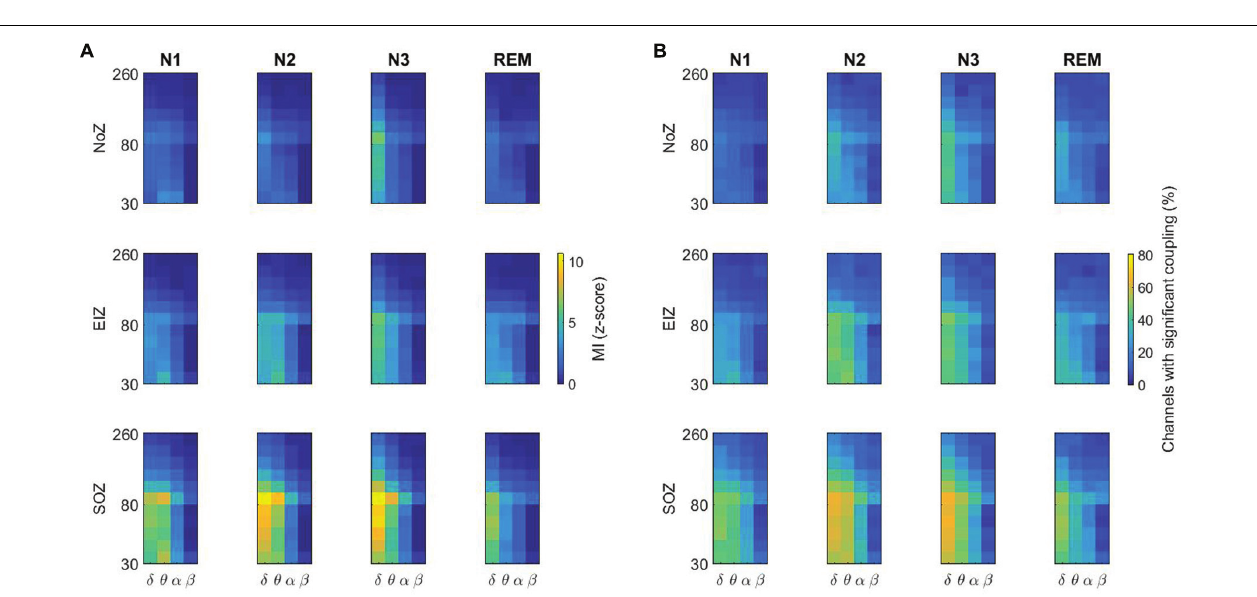
FIGURE 4 | Average PAC quantified by MI in different regions (A) gamma band and low frequencies, (B) ripple band and low frequencies (top: delta, middle: theta, below: alpha); Green: NoZ, Yellow: EIZ, Red: SOZ. ∗ Shows significant difference ( p < 0.05, corrected). Results are plotted as the mean ± SE.